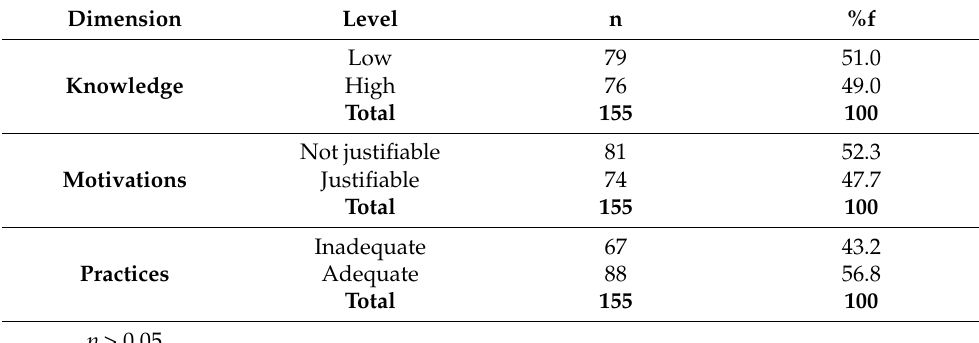
Table 3. Level of perception of the dimension’s knowledge, motivations and practices of academic plagiarism in students at the school of industrial engineering of a public university in Lima. Dimension